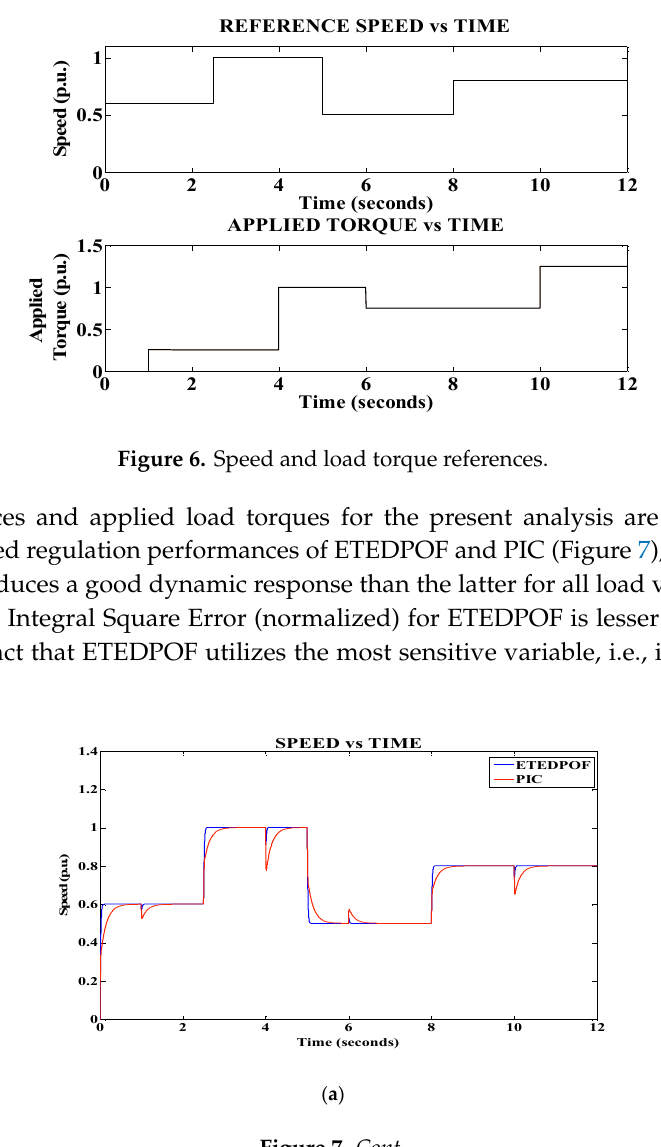
Figure 5. Hardware setup for buck converter-fed DC motor.